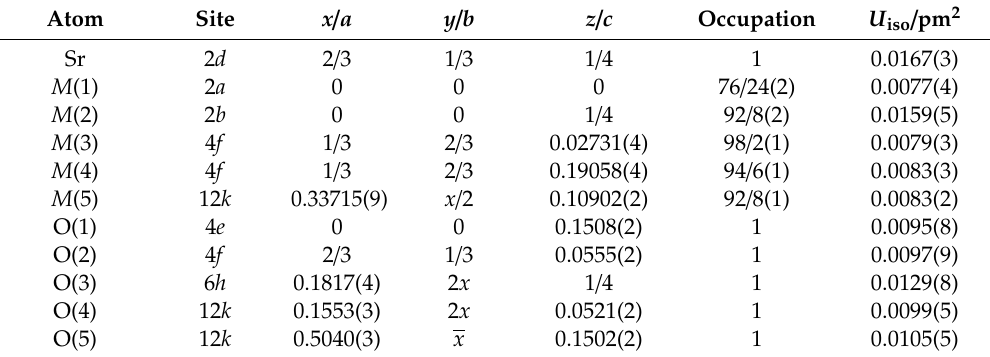
Table 4. Wycko ff sites, fractional coordinates in the asymmetric unit, occupational parameters and isotropic displacement factors for every unique ion site of crystal 3 after annealing in an aluminum